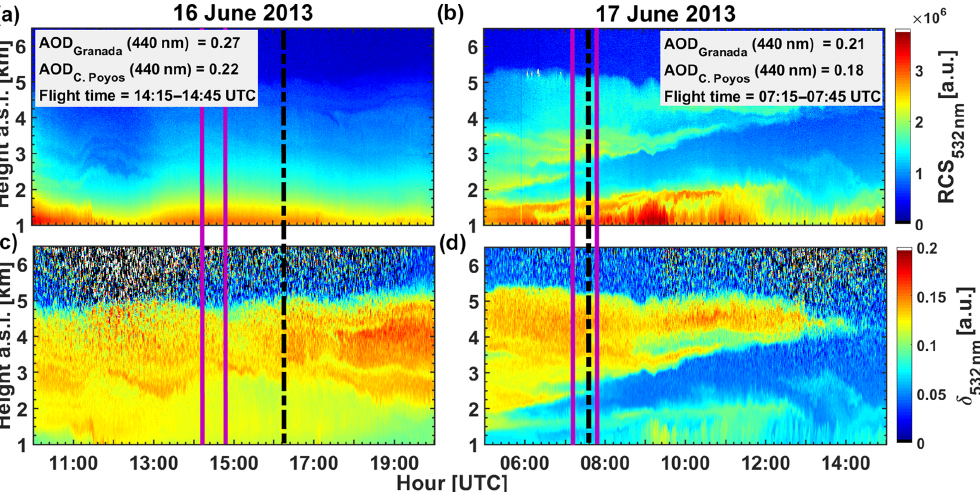
Figure 2. Temporal evolution of the lidar range-corrected signal (a, b) and the depolarization ratio (c, d) at 532nm on 16 (a, c) and 17 (b, d) June 2013. The two purple lines indicate the lidar analysed interval. The black dashed line indicates the sun-photometer